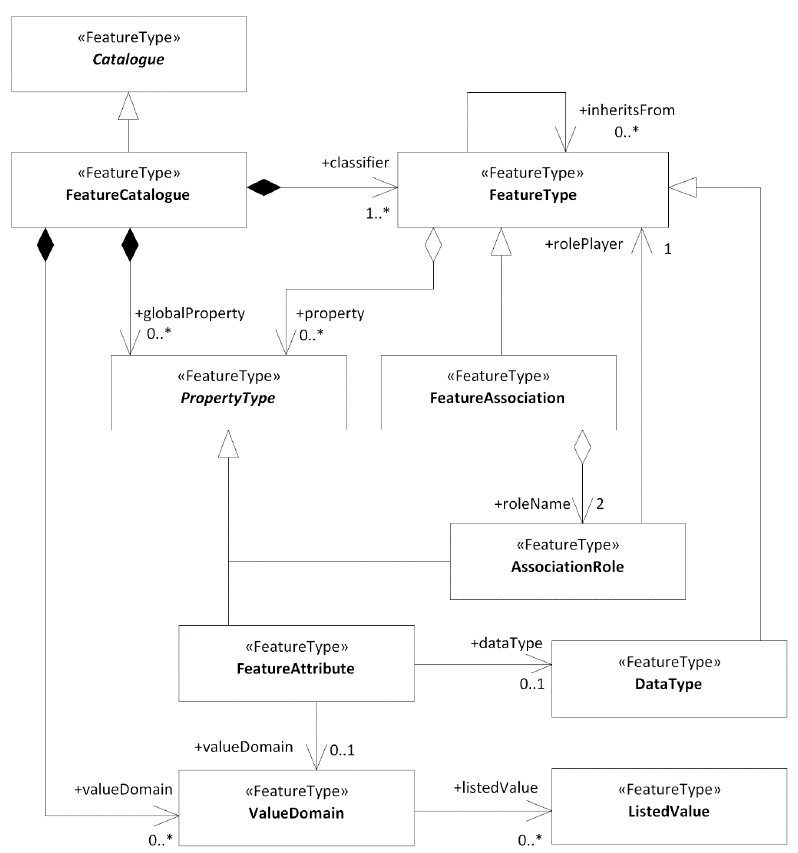
Figure 5. Overview of the Feature Catalogue Exchange Model in the prototype.